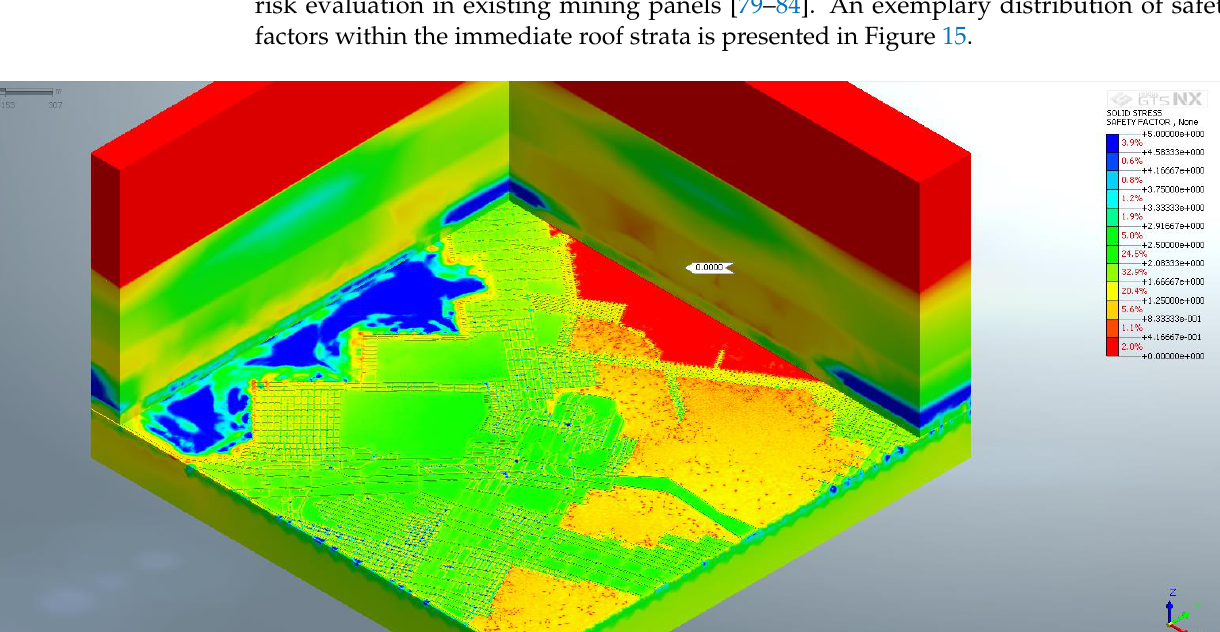
Figure 14. The most commonly used numerical methods in the evaluation of the stability of under- ground workings.